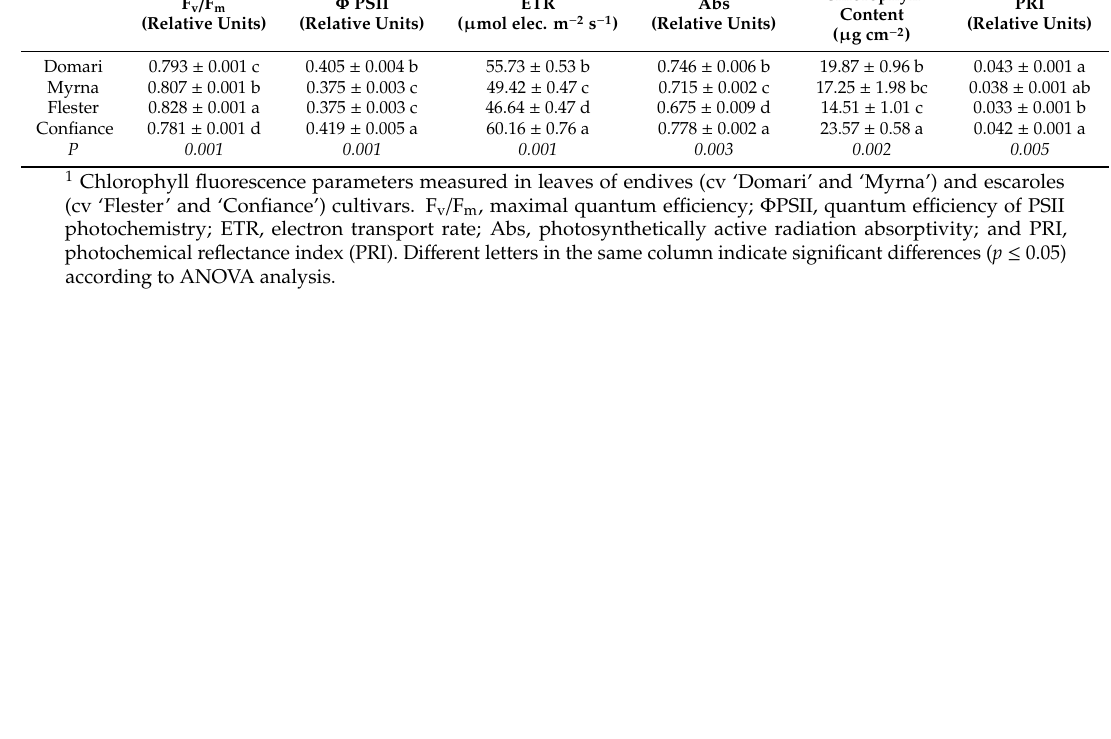
Table 1. Chlorophyll fluorescence parameters of the four C. endivia cultivars.